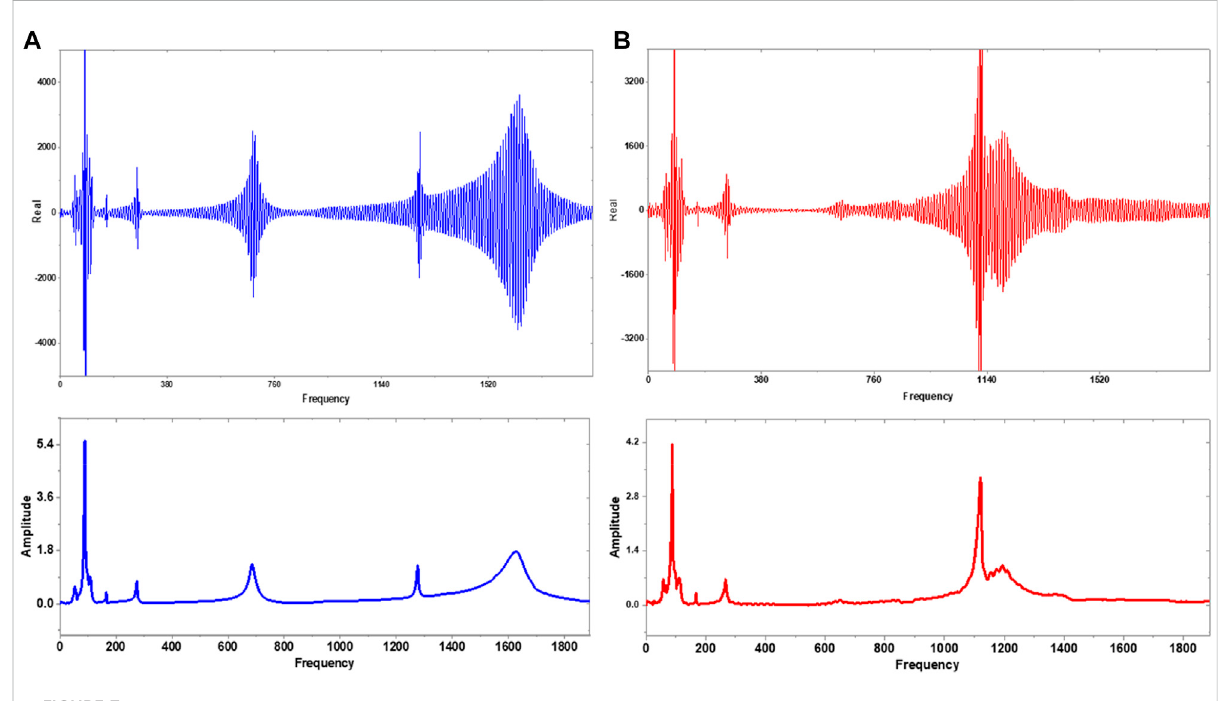
FFT diagram of the processed data, (A) A242 standard alloy, (B) Modi fi ed A242 +